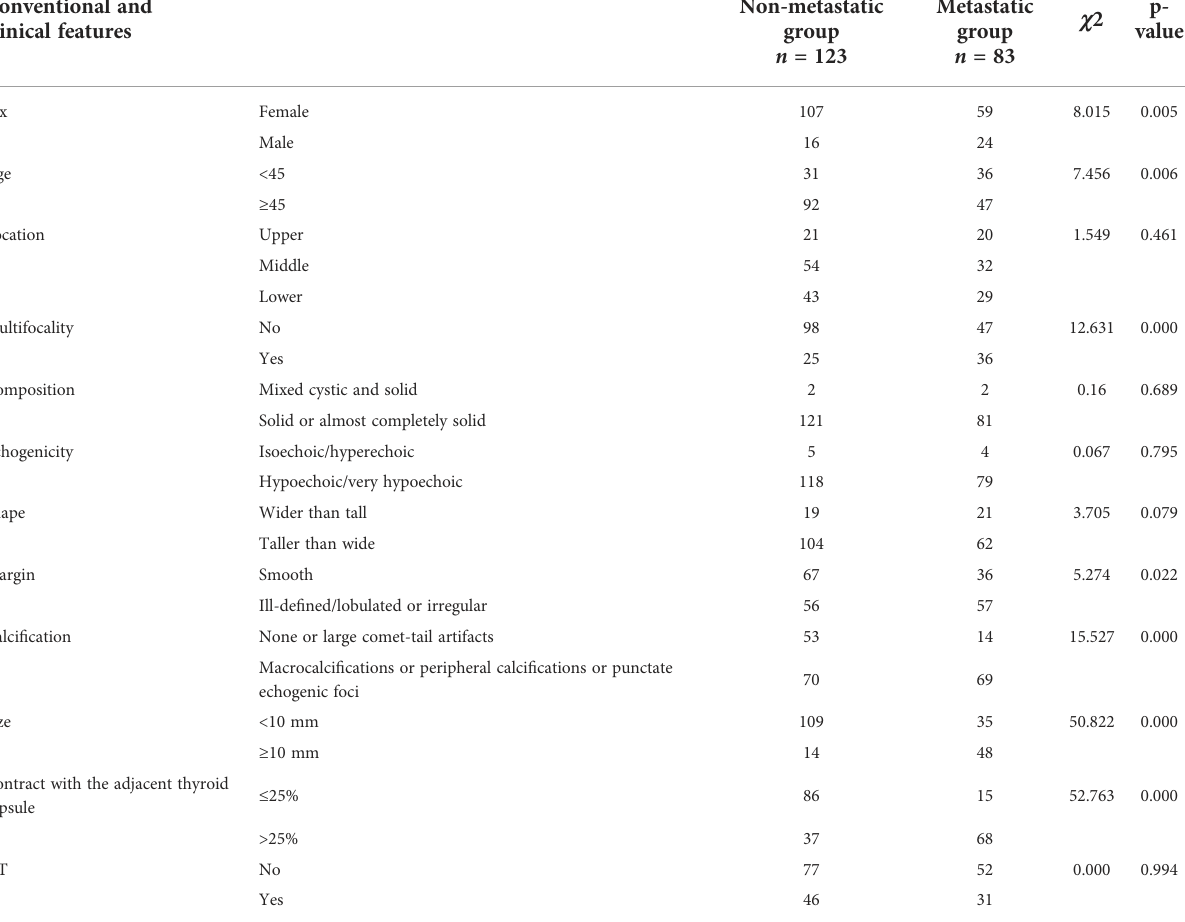
TABLE 1 Clinical data and conventional ultrasound features between the non-metastasis and metastasis group. Conventional and clinical